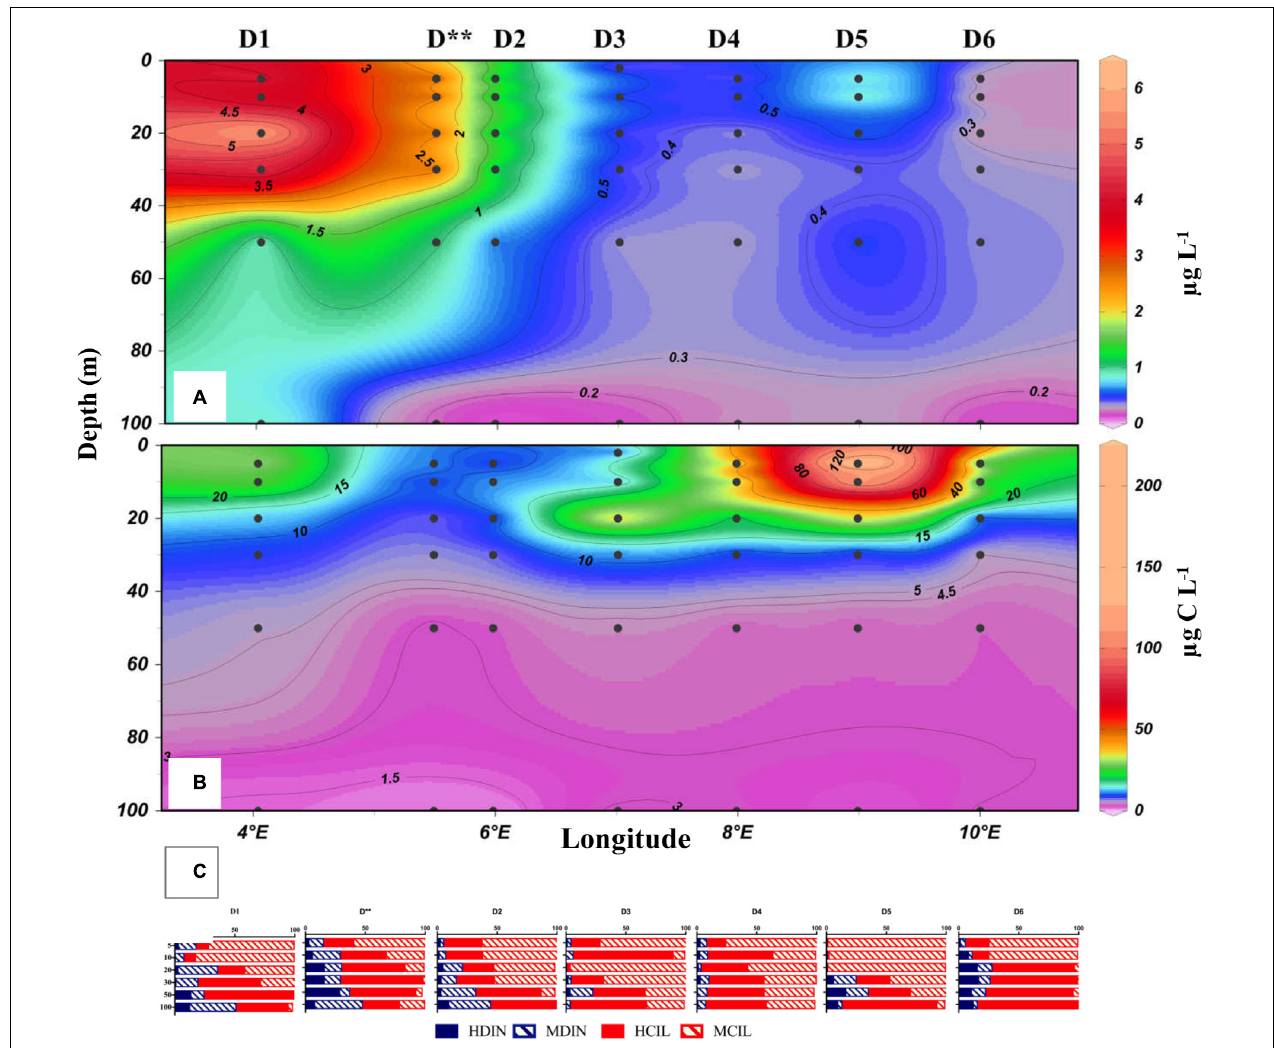
FIGURE 2 | The distribution of chlorophyll a (A) , microzooplankton biomass (B) , and the relative biomass (C) of mixotrophic ciliates (MCIL) and dinoflagellates (MDIN) and heterotrophic ciliates (HCIL) and dinoflagellates (HDIN) in the upper 100 m of the water column along the D transect during the May 2014 Carbon Bridge